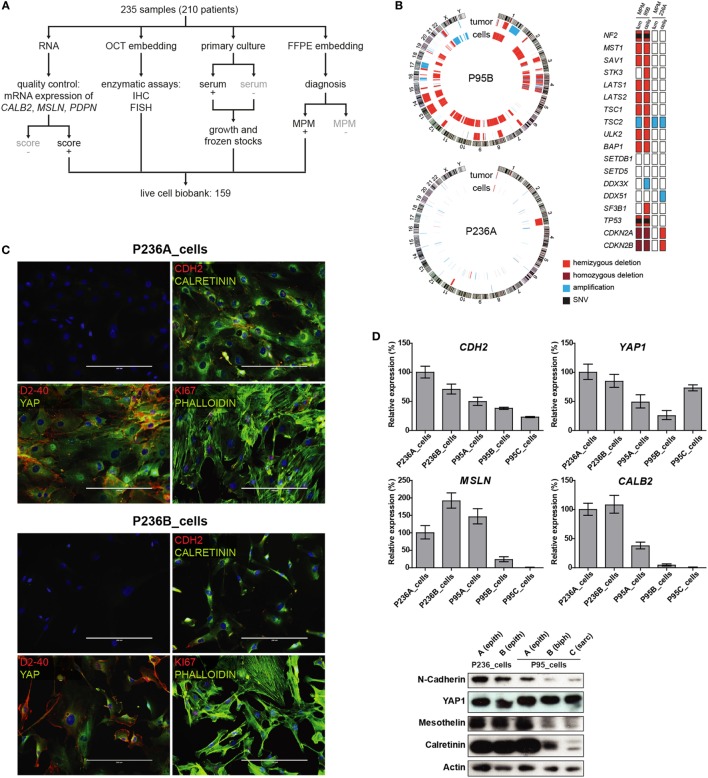
(A) Tumor processing flow-chart of 235 samples, which were processed for RNA extraction, cell culture and embedding either in PFA or OCT. Samples showing attributes which are grayed in the chart, were not used in the live cell biobank. (B) Circos whole genome copy number variations (CNVs) view of tumor and primary cell culture in patients malignant pleural mesothelioma (MPM) 236 and MPM95. The quilt plot highlights the CNV and SNVs in genes that are part of MPM landscape (2). (C) Immunofluorescence analysis of selected markers in primary culture from patient MPM236. Scale bar 200 µm. (D) Selected genes expression analysis at mRNA (upper panel) and protein (lower panel) level in primary cultures derived from samples from two patients, MPM236 and MPM95. The latter one underwent EMT during disease progression. (E) Selected genes expression analysis at mRNA in tumor samples from patients MPM236 and MPM95. (F) Significant correlation between gene expression changes in tumor and primary culture from patient MPM236 at passage 3.